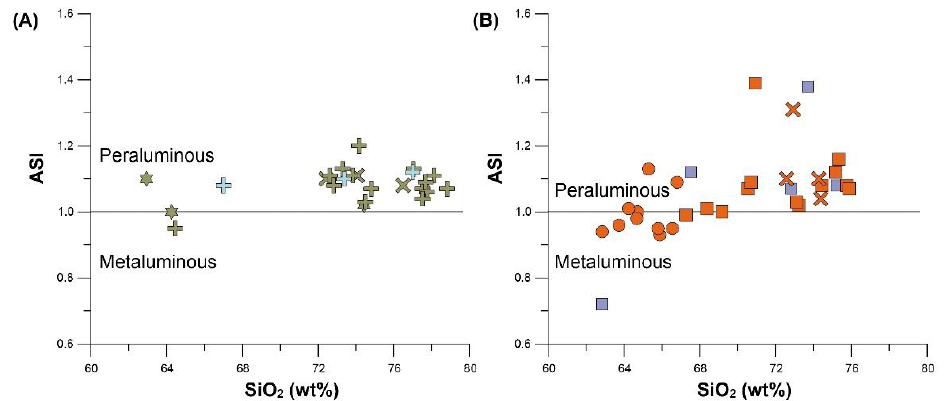
Figure 8. SiO 2 wt.% versus ASI diagram [30] for the Middle Paleoproterozoic orthogneisses ( A ), and Late Triassic granite and Early Jurassic granitic rocks ( B ) in the Jangsu-gun area. ASI: Al/(Ca − 1.67P+Na+K). Symbols are as in Figure 6.